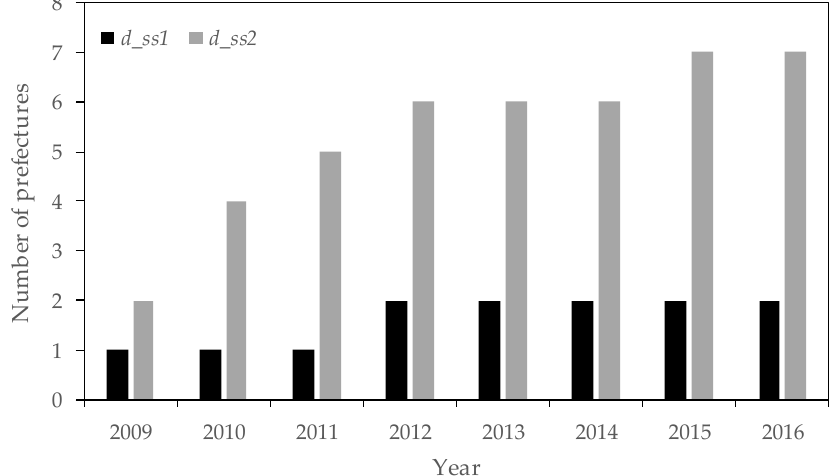
Figure 2. Number of prefectures introducing their own policy measures for LLQH. d_ss 1 shows prefectures introducing policy measures that only cover LLQH, whereas d_ss 2 shows prefectures introducing policy measures that cover LLQH and other types of housing.